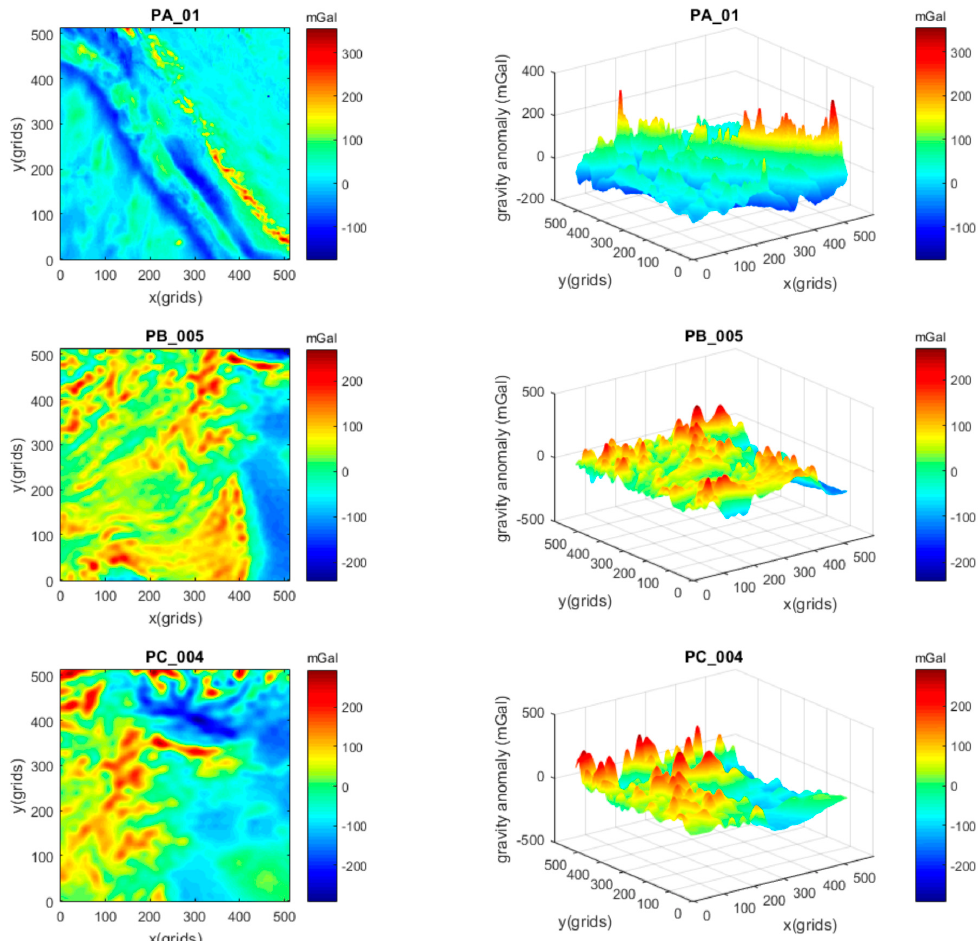
Figure 3. Gravity maps PA_01, PB_005, and PC_004.